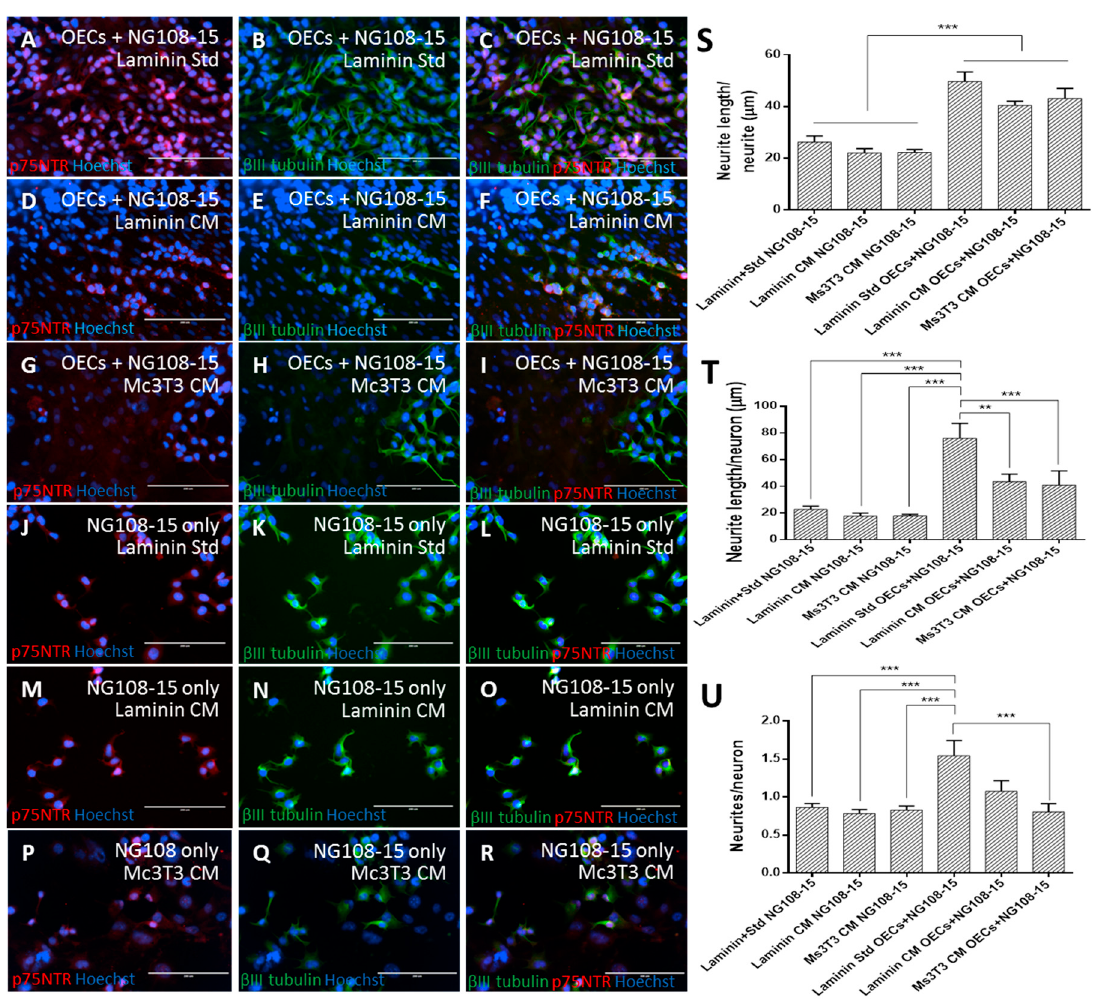
Figure 5. PA5 cells were co-cultured with NG108-15 neurons for five days under different matrix and media conditions. NG108-15 cells were also cultured in isolation to ensure that any improvement observed could be reliably attributed to the PA5 cells as opposed to the matrix and media conditions. After five days of NG108-15 culture, cells were fixed and stained for β III-tubulin and p75NTR ( A–R ). The NeuronJ plugin in for Image J was used to quantify the neurite outgrowth, and measurements were made for neurite length / neurite ( S ), neurite length / neuron ( T ), and neurites / neurons ( U ). The scale bars represent 200 µ m. Data are the means ± SEM, n = 3.